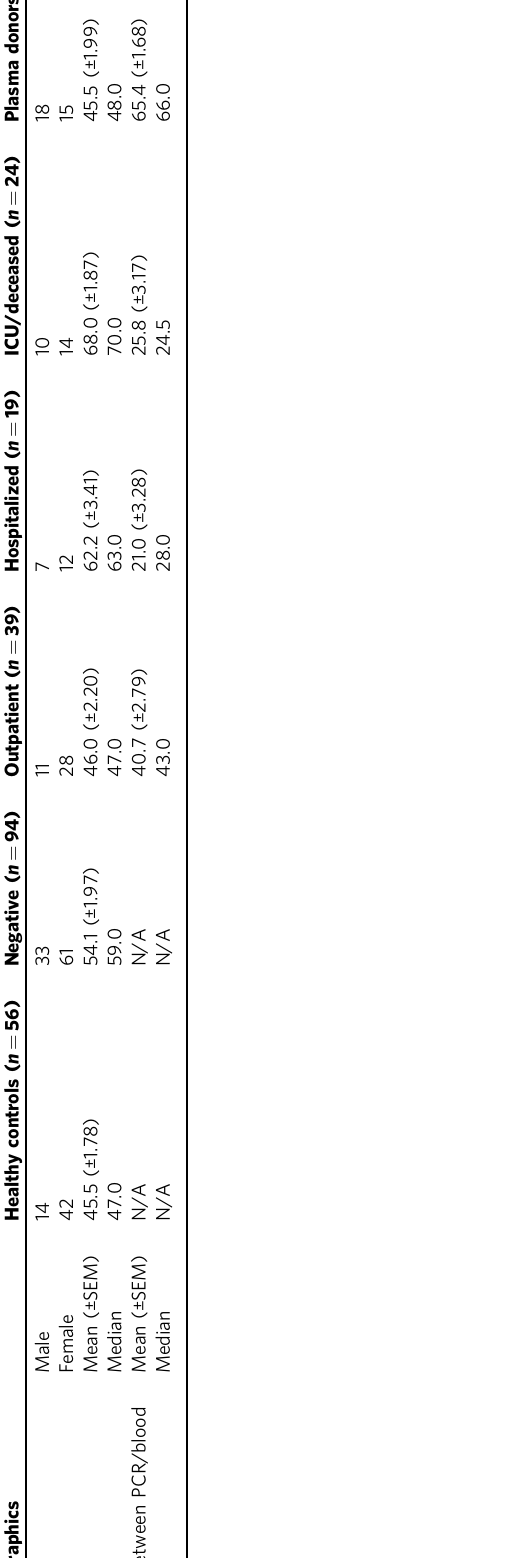
Fig. 4. Healthy control plasma samples were used as negative (Fig. 5a). None of the control plasma ( n = 34, 1 shown in Fig. 5a) tested showed any neutralization activity, whereas patient plasma (Fig. 5a). The 50% neutralization titer (NT50) was determined using the half-maximal inhibitory concentration values of plasma samples, normalized to control infections, from their serial T